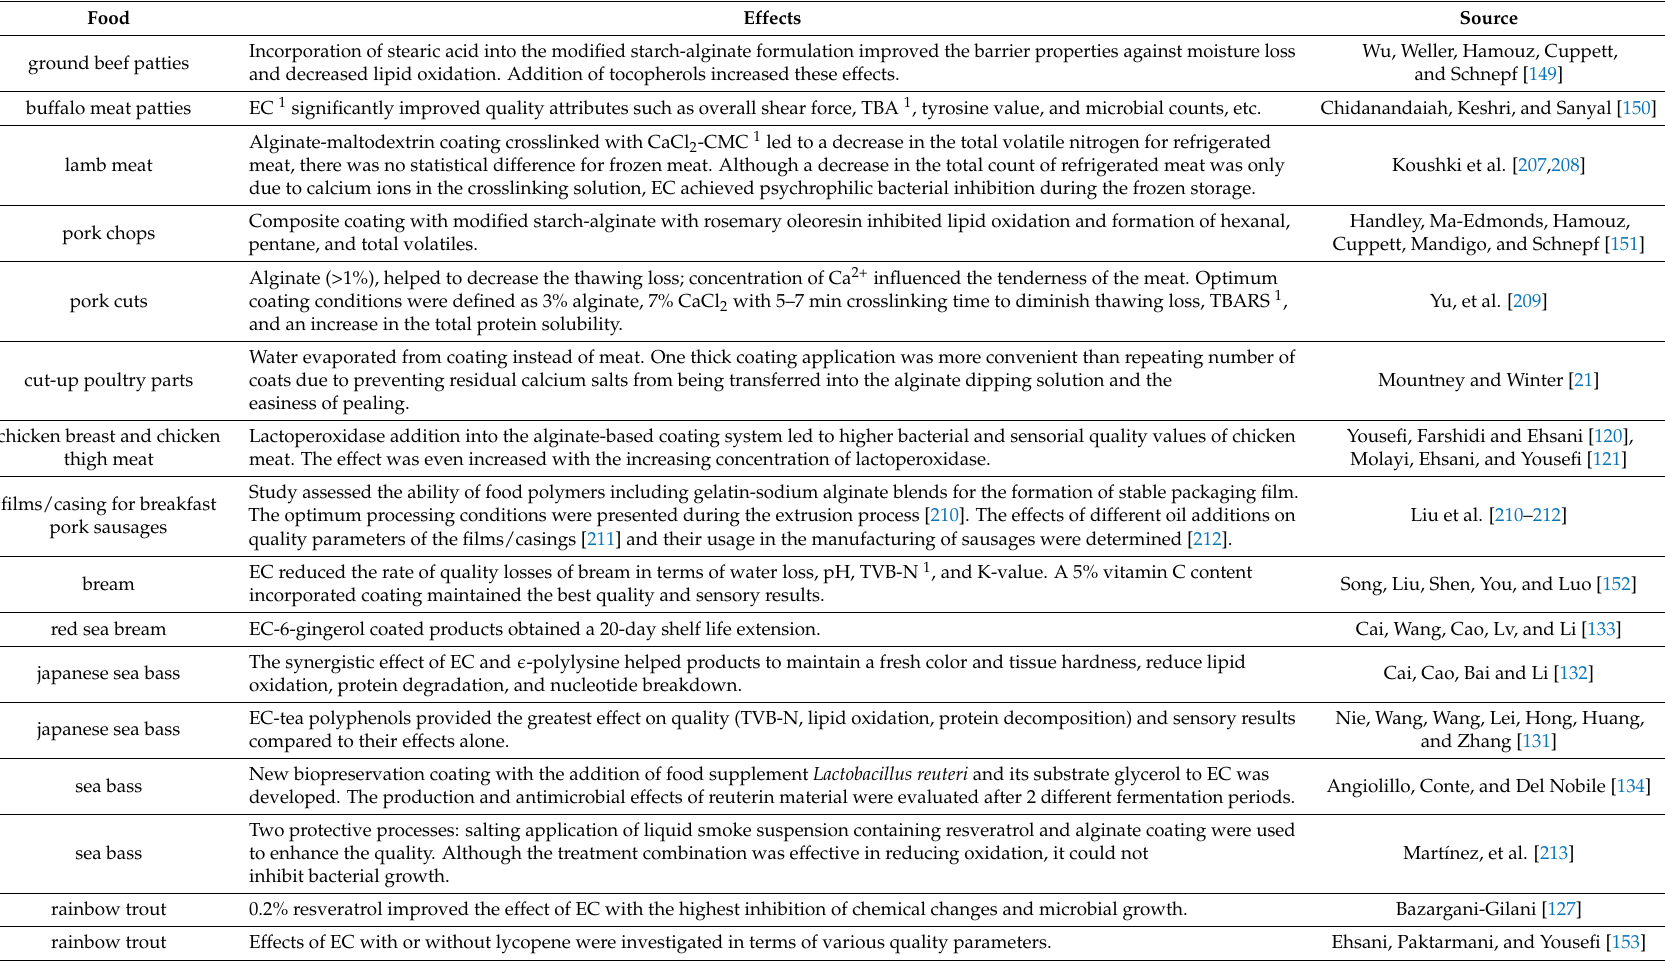
Table 4. The application of alginate coating on meat, poultry, and seafood